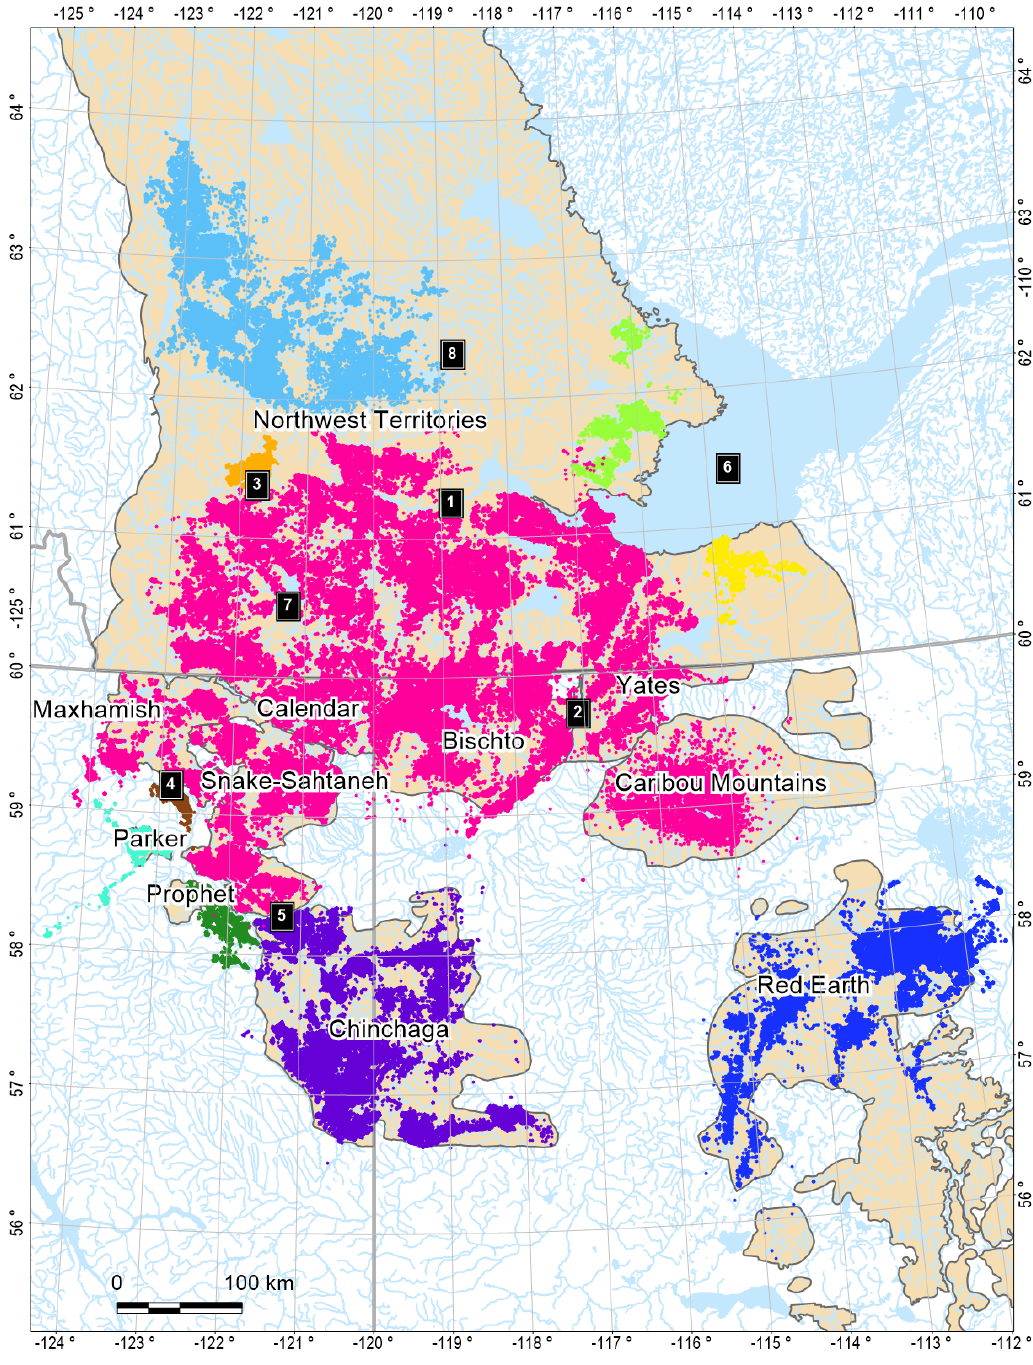
Fig. 4. Results of cluster analyses based on the spatial cluster graphs for the 10-group solution. Each colour repre- sents a distinct group. Points noted in the text are labelled: 1) Mackenzie River; 2) Hay River; 3) Liard River; 4) Fort Nelson River; 5) Fontas River; 6) Great Slave Lake; 7) Trout Lake; and 8) Edéhzh